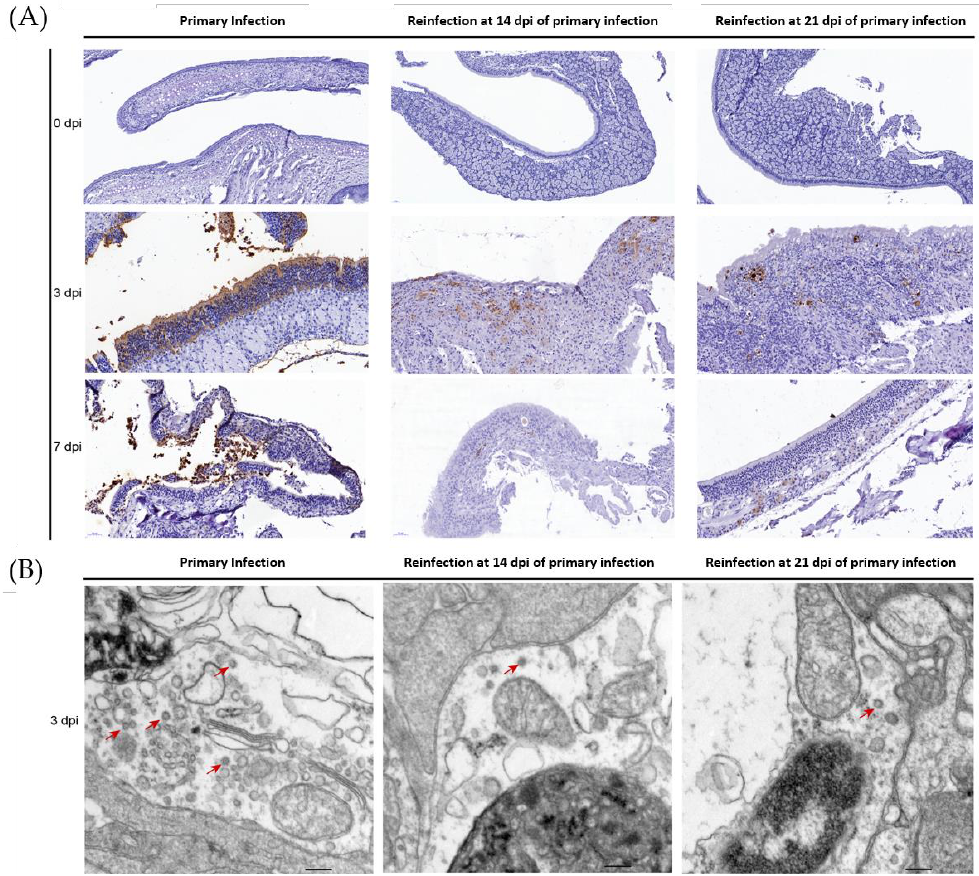
Figure 3. Viral distribution and virions were present in the nasal mucosa during reinfection, while higher levels of viral distribution and virions were observed during primary infection. ( A ) The distribution and abundance of SARS-CoV-2 in the nasal mucosa were detected by SARS-CoV-2-N protein-IHC, and the nasal mucosa was detected at 0 dpi, 3 dpi, and 7 dpi in the primary and secondary infection groups. ( B ) SARS-CoV-2 virions in nasal mucosa were detected by ultrathin section TEM. The scale is 200